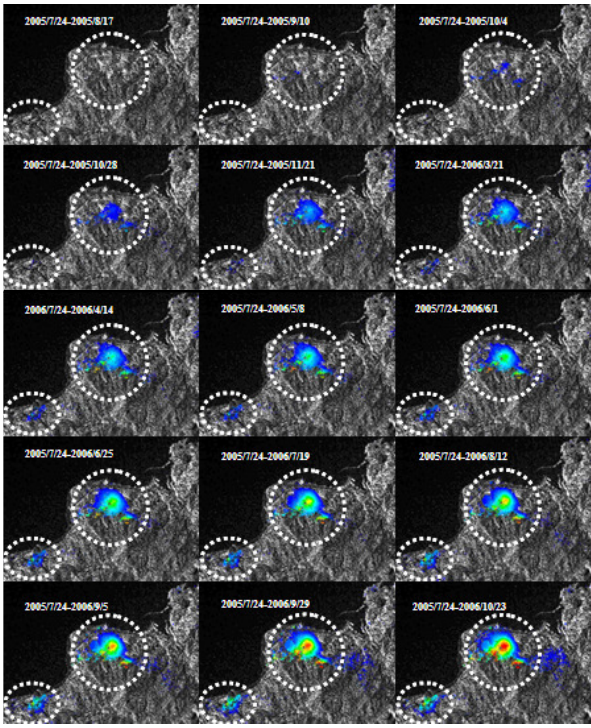
Figure 6. Temporal deformation developments from the D-InSAR pairs Fig. 6. Temporal deformation developments from the D-InSAR